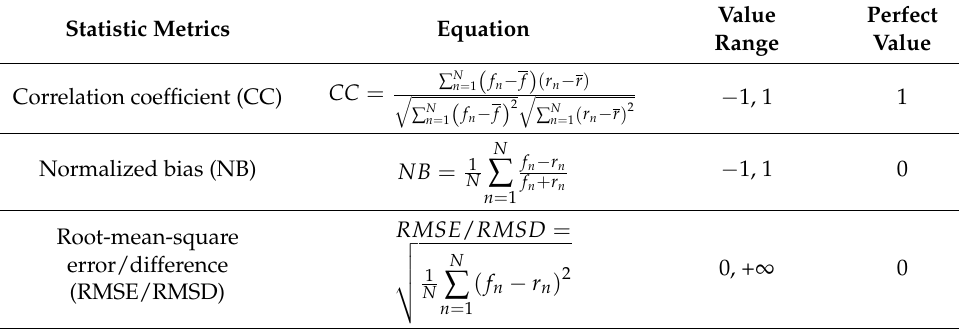
Table 2. List of statistical